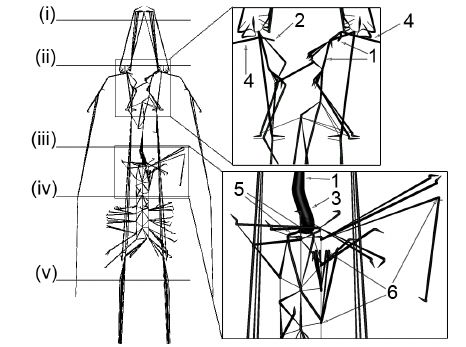
Figure 1. The graph of the lymphatic system: (i) — head, (ii) — neck, (iii) — diaphragm, (iv) — elbows, (v) — groin; 1 — thoracic duct, 2 — right lymphatic duct, 3 — cisterna chyli, 4 — subclavian trunks, 5 — lumbar trunks, 6 — lymph